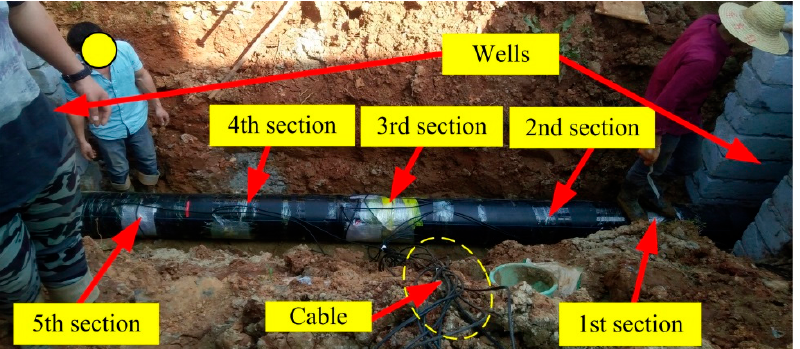
Figure 1. The buried polyethylene (PE) pipe used in the experiment.